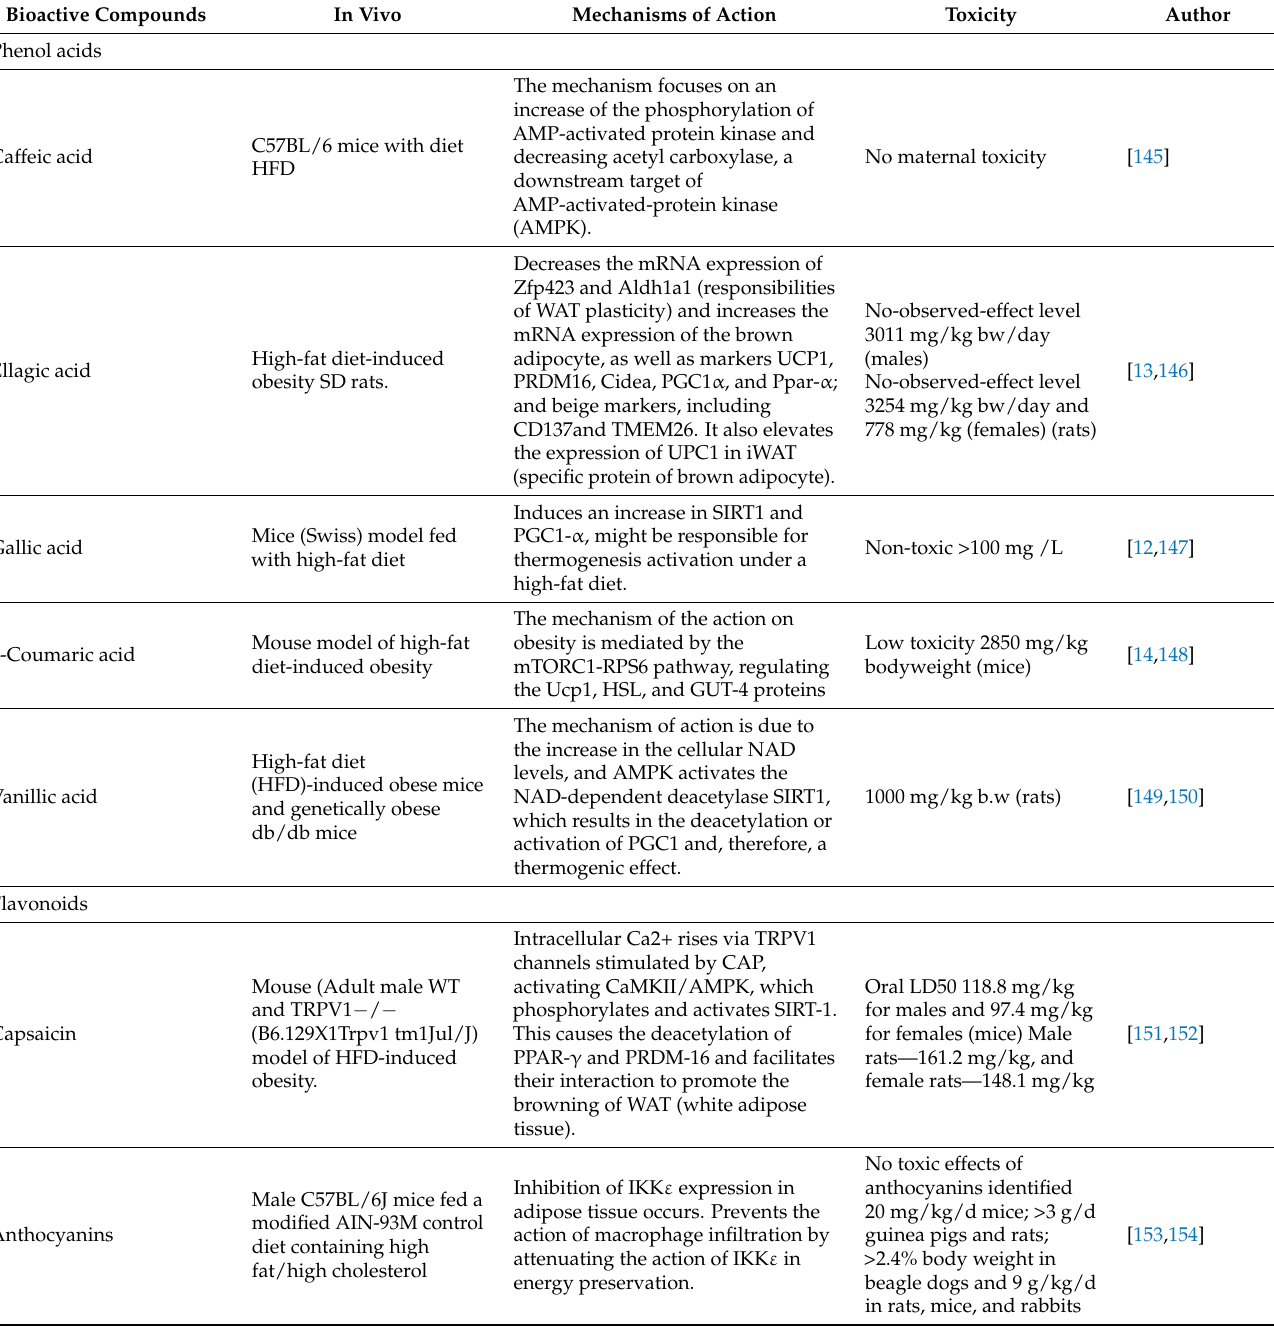
Table 3. Molecular mechanisms of bioactive compounds on animal models of